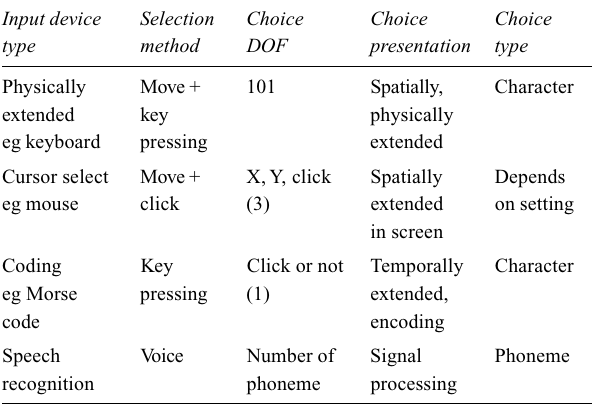
Table 1 Comparison between different types of input